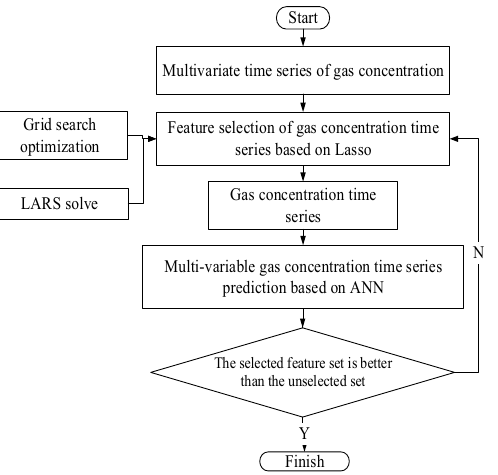
Figure 4. Flow chart of the construction and optimization of the gas concentration time series feature selection algorithm based on